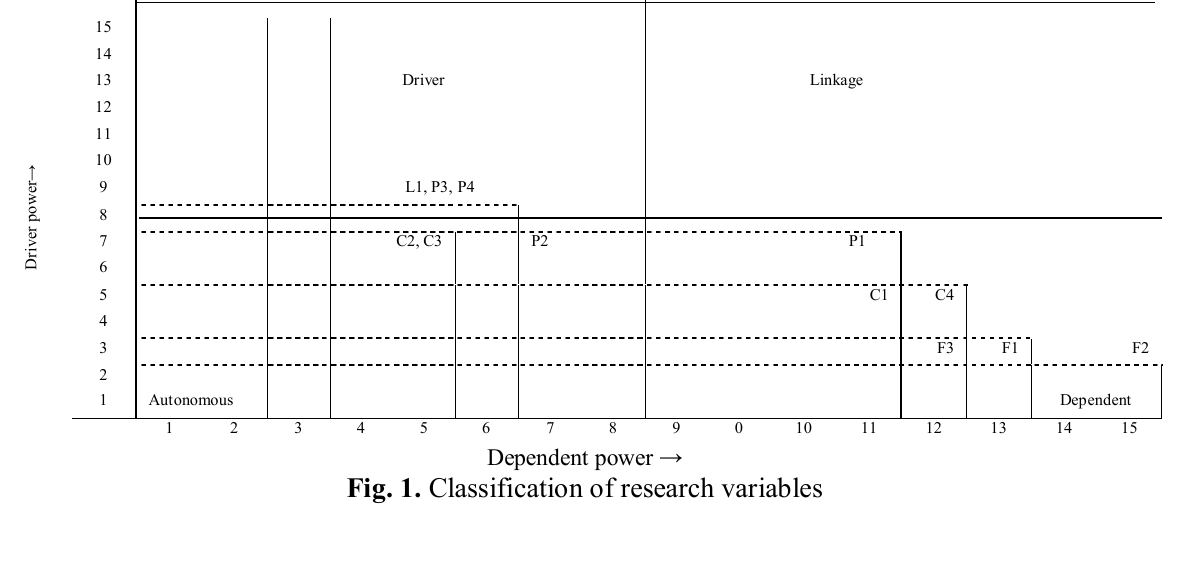
Leveling of reachability matrix